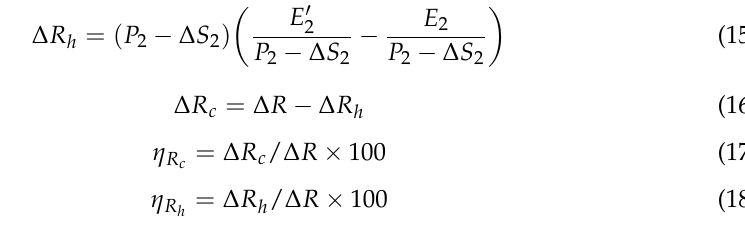
Figure 3. Schematic of the decomposition method for quantifying the climatic and anthropic fac ‐ tors on runoff.